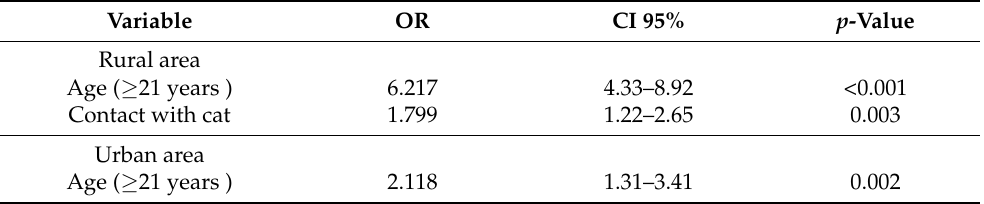
Table 3. Final model of multiple logistic regression between the studied variables and anti- T. gondii IgG seropositivity in individuals residing in rural and urban areas of the municipality of Ponta de Pedras, Par á , Brazil, from August 2015 to April 2018.